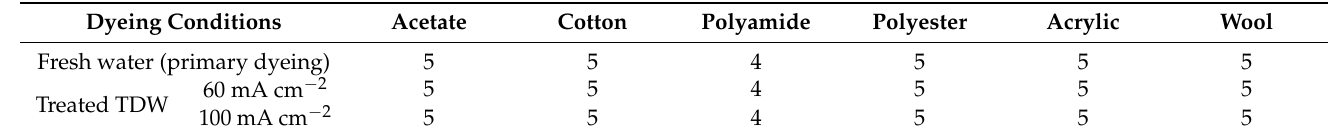
Table 5. Color fastness to washing of the wool fabrics dyed using fresh water (primary dyeing) and TDW treated by EO (scale: 1 (poor) to 5 (excellent)). Dyeing Conditions Acetate Cotton